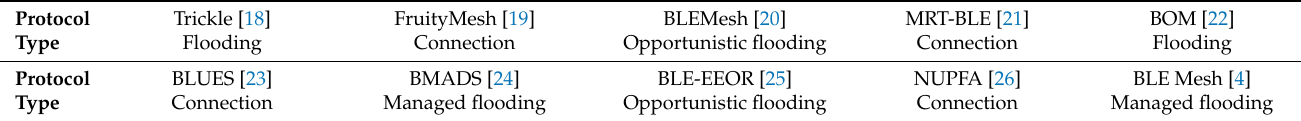
Table 1. Selected list of the current BLE mesh